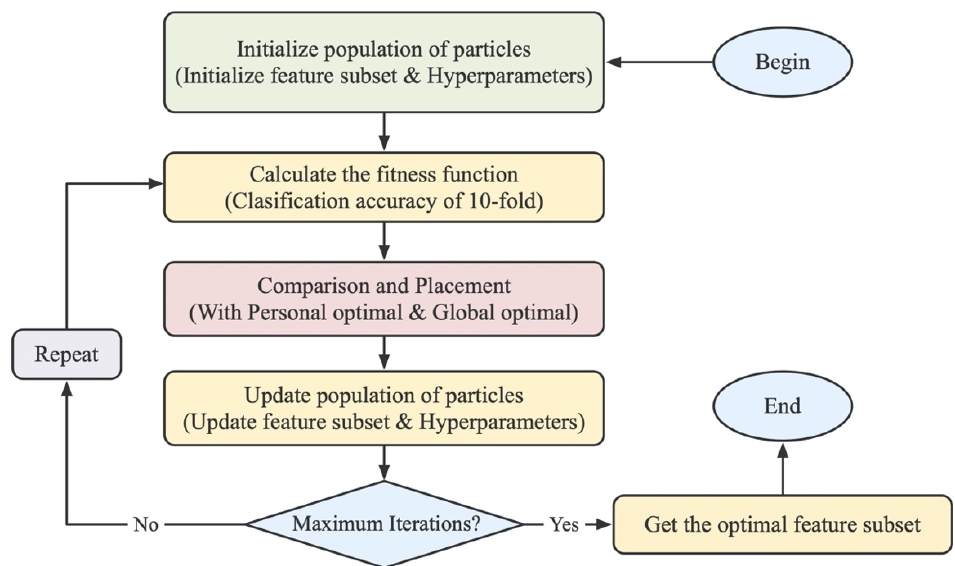
Figure 2. Flow chart of the BPSO algorithm. The particles are first initialized, and then the fitness value of each particle is calculated. The fitness value is used to iteratively update the velocity and position, in order to find the optimal feature subset of feature descriptors.